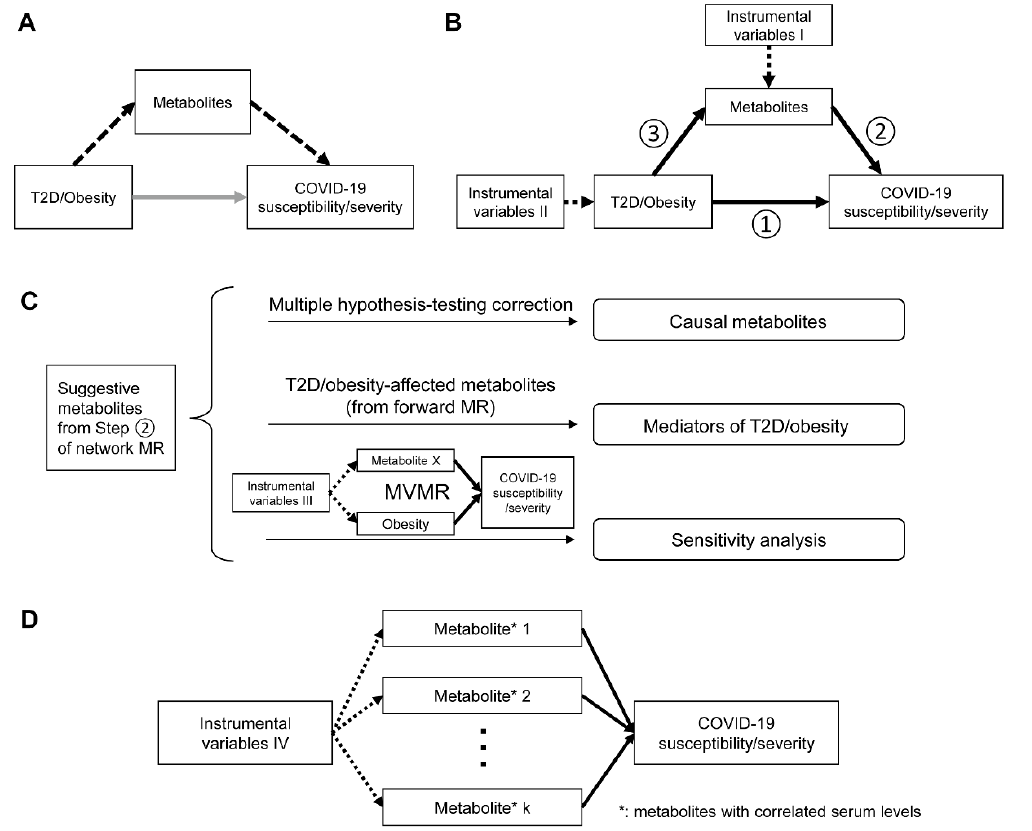
Figure 1. Overview of the study design. ( A ) Directed acyclic graphs illustrating the hypothetical causal model of T2D/obesity, metabolites, and COVID-19 susceptibility/severity. Dashed arrow: indirect effect via mediator; grey arrow: direct effect. ( B ) Framework of network Mendelian randomization. The analysis flow started from the estimation of total effect of T2D/obesity on the outcomes ( 1 (cid:13) ), followed by outcome-related metabolite screening ( 2 (cid:13) ). The final step in the network MR was an assessment of the causality between metabolites and T2D/obesity ( 3 (cid:13) ). Dashed arrow: instrumental variables of exposures; black arrow: directions of causal association. ( C ) Further analyses on the metabolites with suggestive associations with outcomes from network MR. These analyses included multiple hypothesis-testing corrections to prioritize credible causative metabolites, multivariable Mendelian randomization for single metabolites adjusting for BMI, and mediation analysis to identify the mediators. Dashed arrow: instrumental variables of exposures; black arrow: directions of causal association. ( D ) Multivariable Mendelian randomization for metabolites with correlated serum levels. Dashed arrow: instrumental variables of exposures; black arrow: directions of causal association.